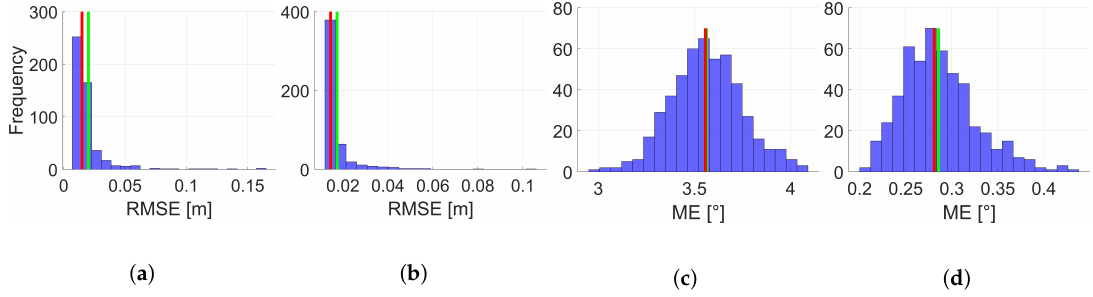
Figure 9. Histograms of the RMSE for position by means of 500 replications for combination III (moderate IMU ( a )) and combination III (accurate IMU ( b )) of state constraints applied. Related histograms of the ME for orientation by means of 500 replications for combination X (moderate IMU ( c )) and combination III (accurate IMU ( d )) of state constraints applied. Respective mean is given by a red bar and respective median by a green bar. The Roman numerals refer to respective state constraints applied regarding Table